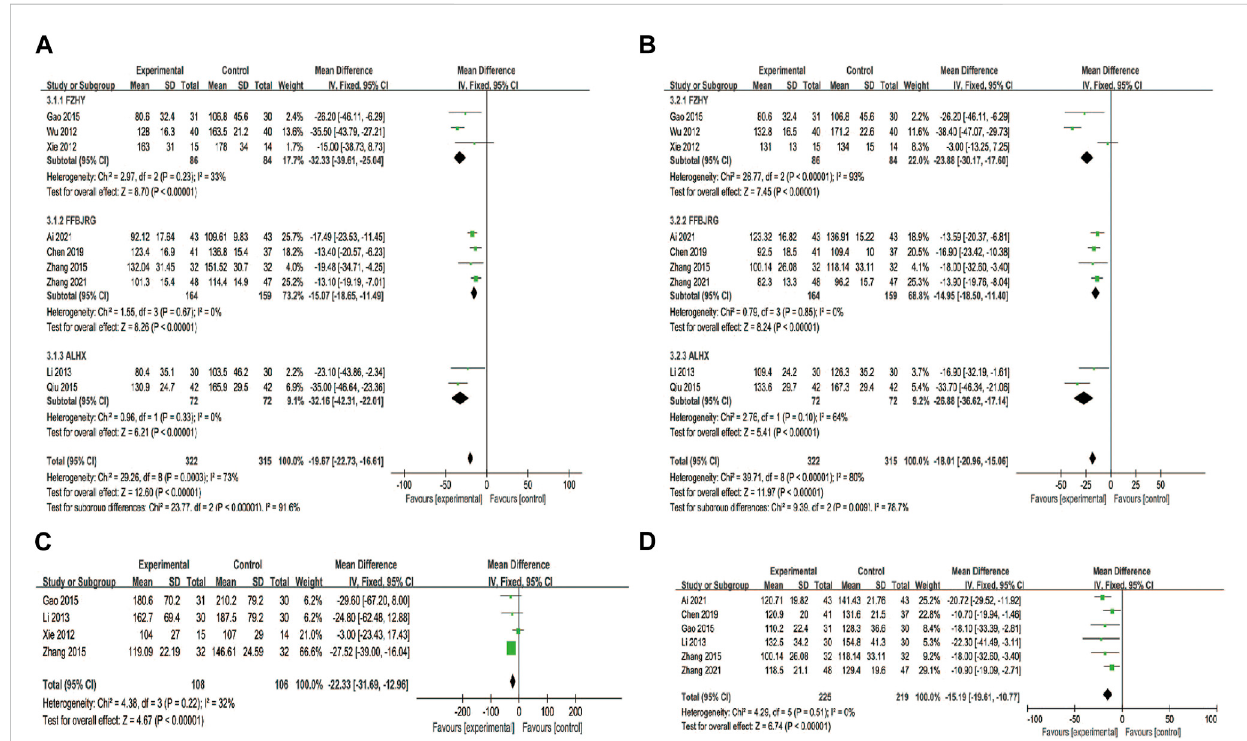
FIGURE 6 Forest plot of meta-analysis of liver fi brosis (A) laminin; (B) type IV collagen (C) hyaluronic acid; and (D) type III procollagen.